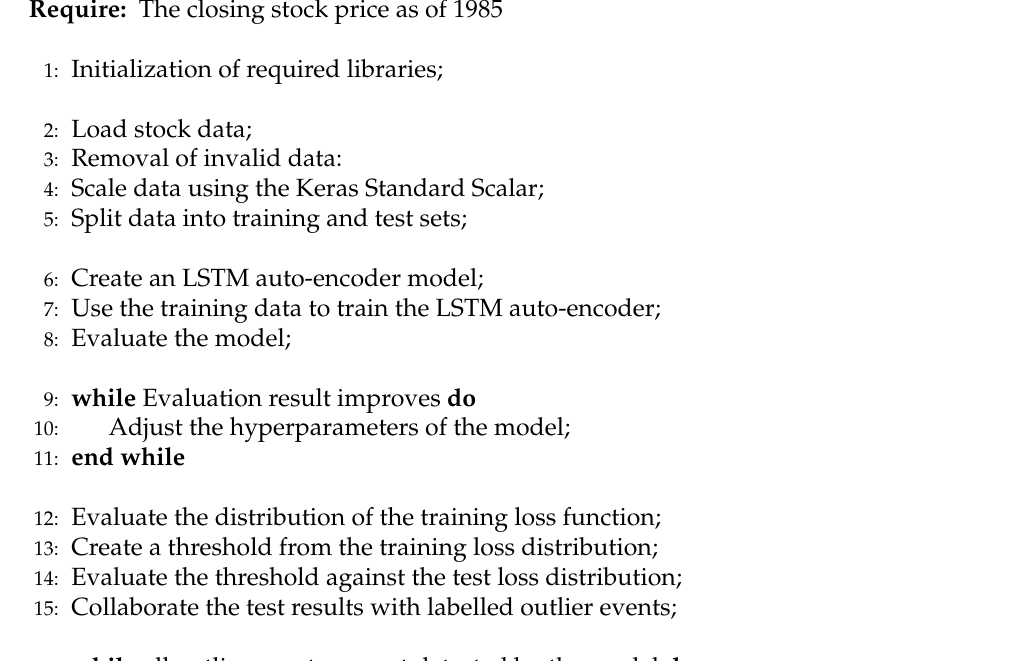
Algorithm 1 An LSTM